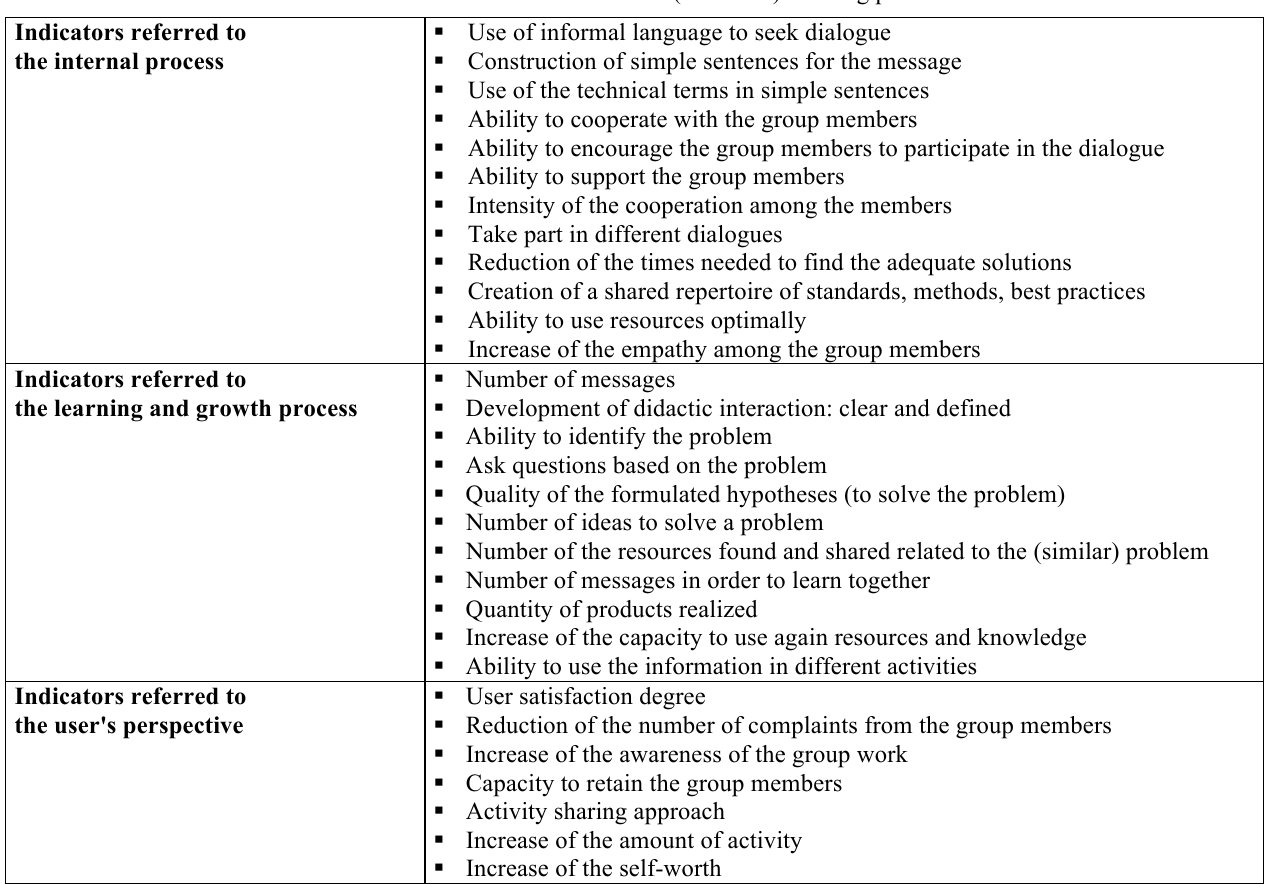
Table 2. Indicators to evaluate the (in-itinere) learning